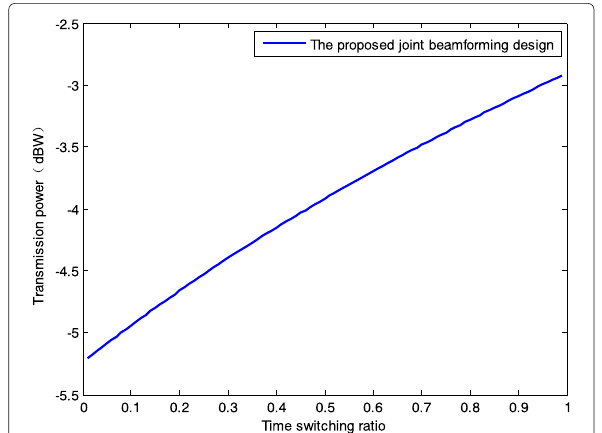
Fig. 4 The relation between transmission power and time switching